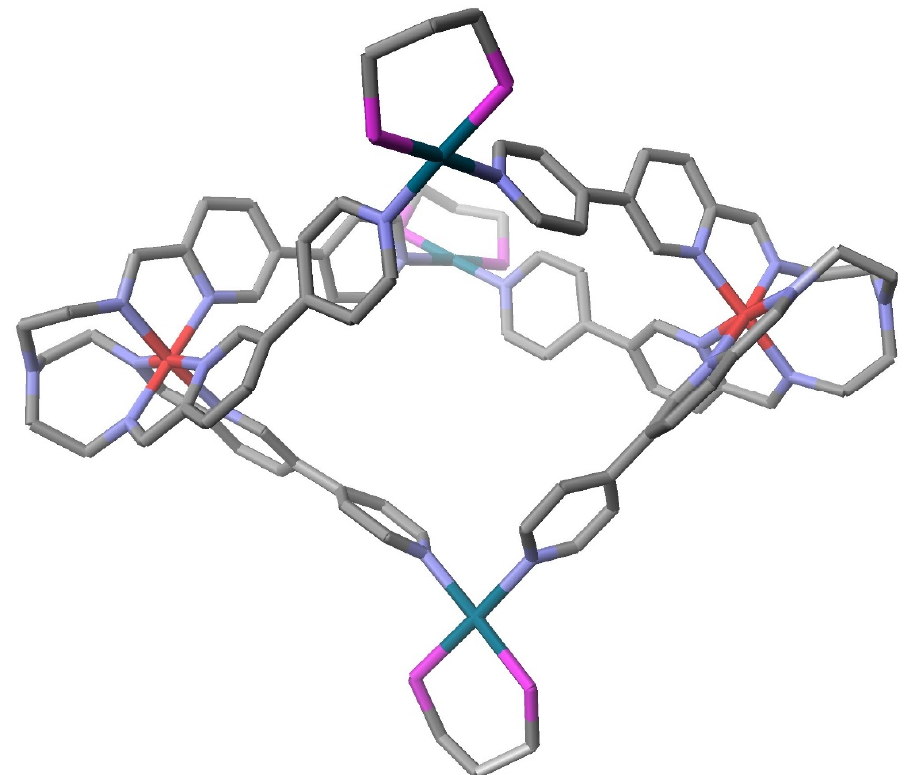
Figure 14. A Fe 2 Pd 3 supramolecular complex, {[Fetren(5(-4-pyridyl)Py) 3 ] 2 [Pd(dppe)] 3 } 10 + , where the iron atoms occupy the axial sites and the palladium atoms the equatorial sites. All hydrogen atoms, phenyl groups of the dppp ligand, anions, and solvent have been omitted for clarity. The structural parameters of the iron(II) are consistent with a LS assignment.